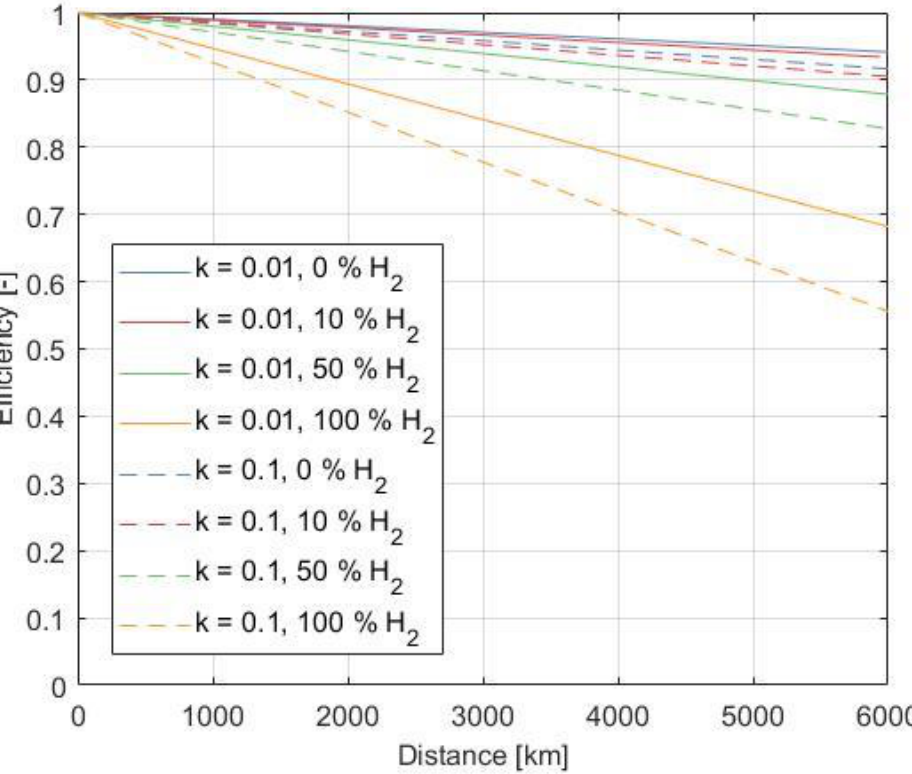
Figure 9. Influence of wall roughness on transport efficiency.